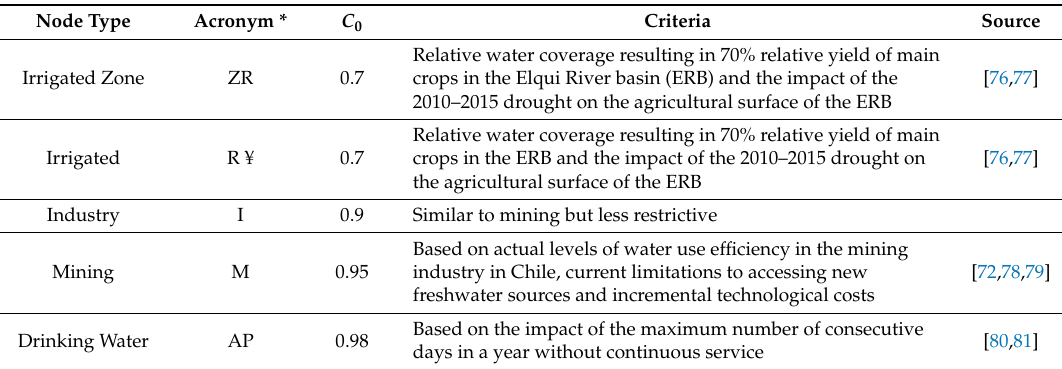
Table 1. Threshold value ( C 0 ) as a function of node